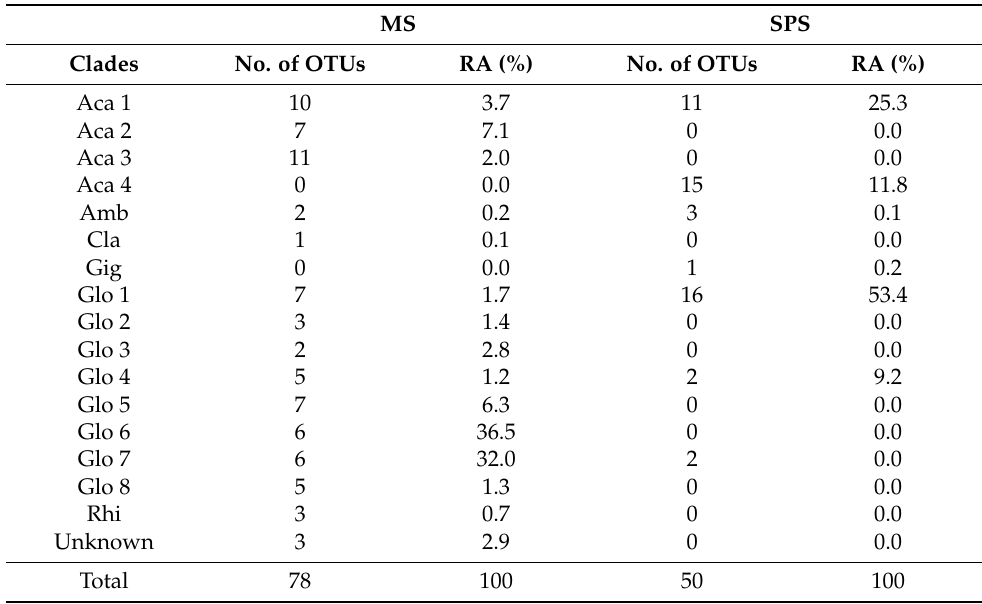
Table 2. The number of operational taxonomic units (OTUs) and relative abundance (RA) in each clade. MS SPS Clades No. of OTUs RA (%) No. of OTUs RA (%) Aca